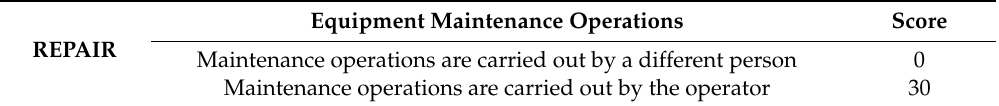
Table 5. Exposure factors during in-field maintenance of the application equipment.